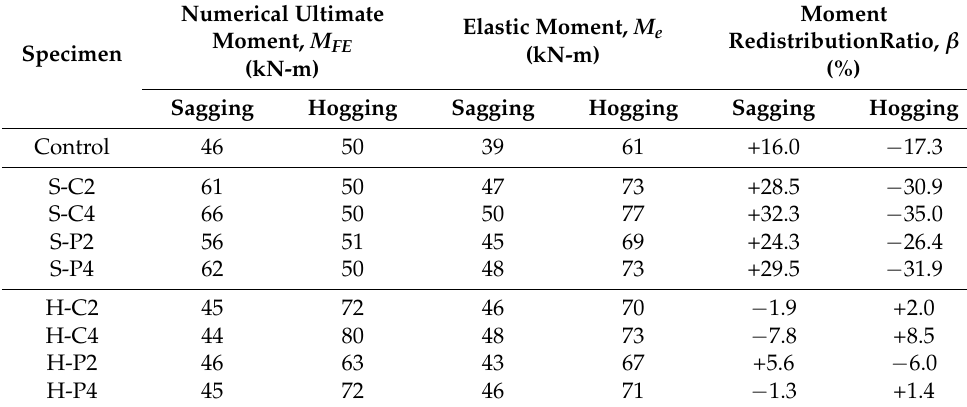
Figure 19. Numerical load–moment relationships: ( a ) Group A (sagging strengthening); ( b ) Group B (hogging strengthening). Table 9. Numerical moment redistribution at ultimate load. Table 9. Numerical moment redistribution at ultimate load.